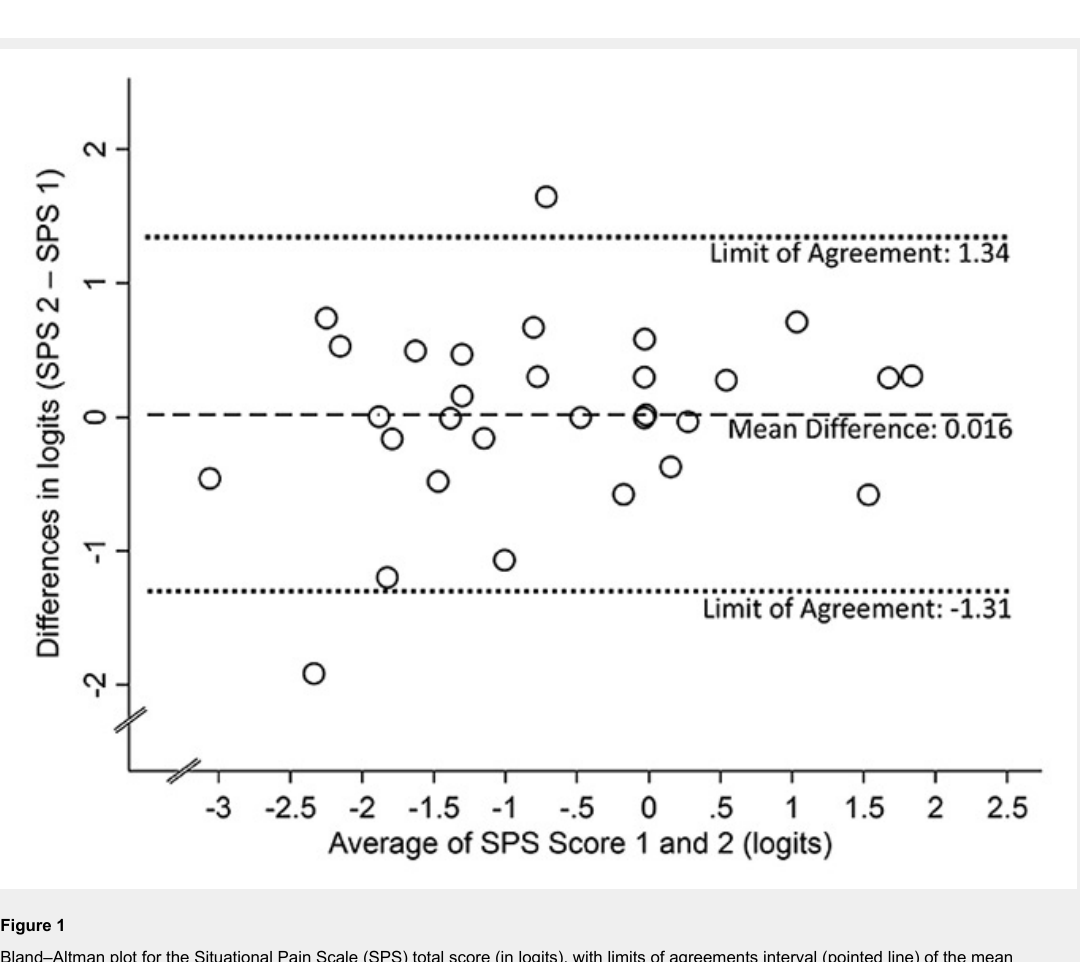
Bland–Altman plot for the Situational Pain Scale (SPS) total score (in logits), with limits of agreements interval (pointed line) of the mean difference (dashed line) between the two assessment